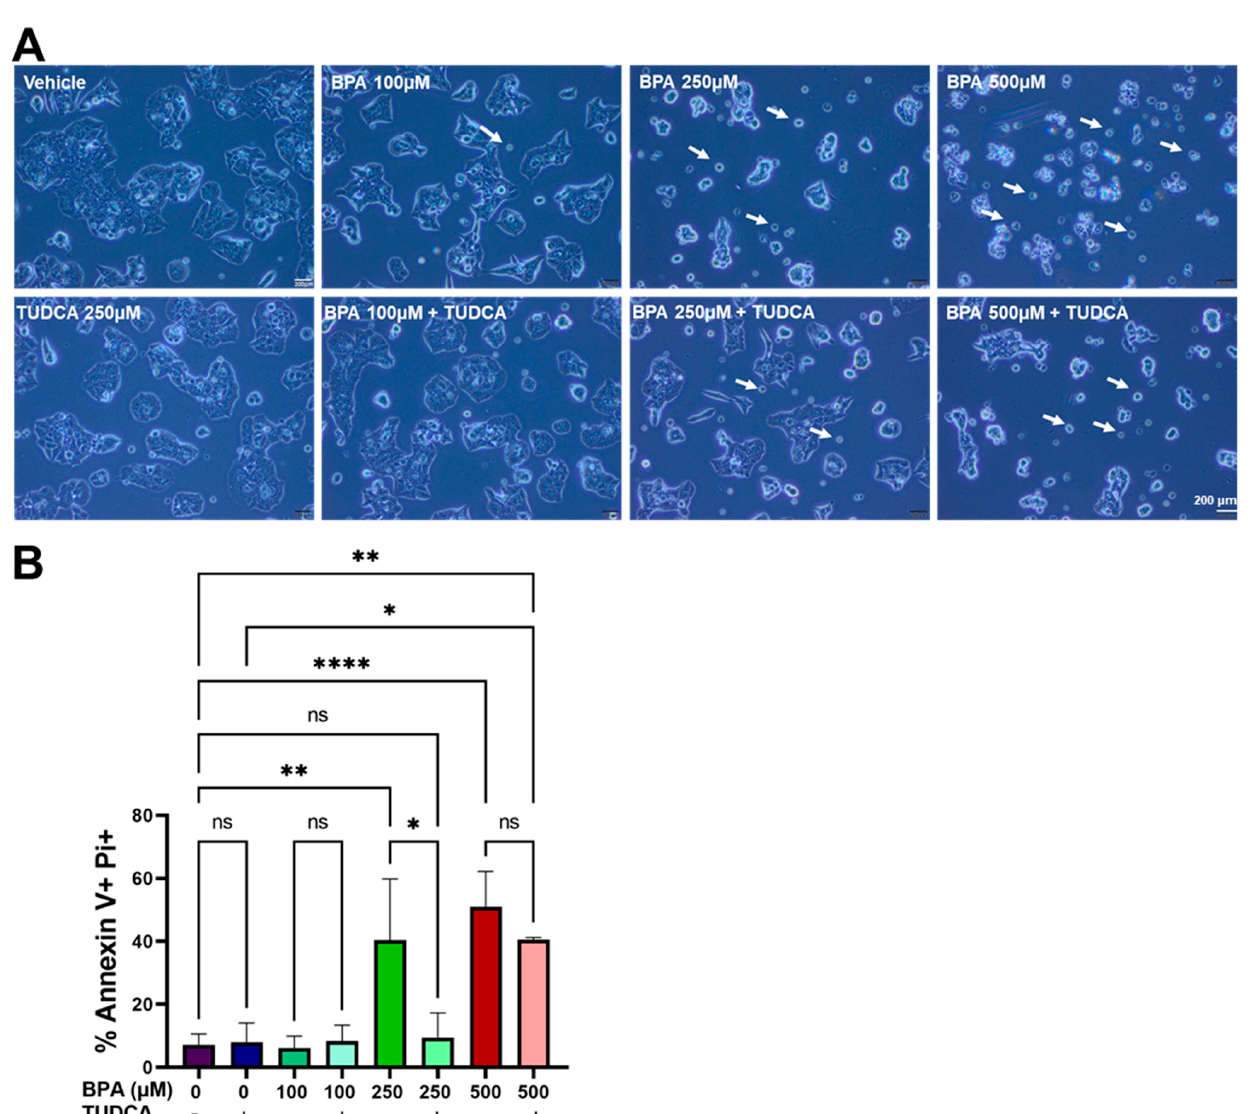
Figure 5. Co-treatment of BPA with TUDCA reduces the death of MIN6 cells. ( A ) Representative brightfield microscopy images with MIN6 cells after 24 h of treatment with BPA (0–500 µM) in the presence or absence of TUDCA 250 µM. ( B ) Apoptosis of MIN6 cells exposed to BPA and TUDCA was determined by flow cytometry upon co-staining with Annexin V and PI. ns—not significant, * p < 0.05, ** p < 0.005, **** p < 0.0001 based on One way ANOVA. Graphs represent the mean ± SD.